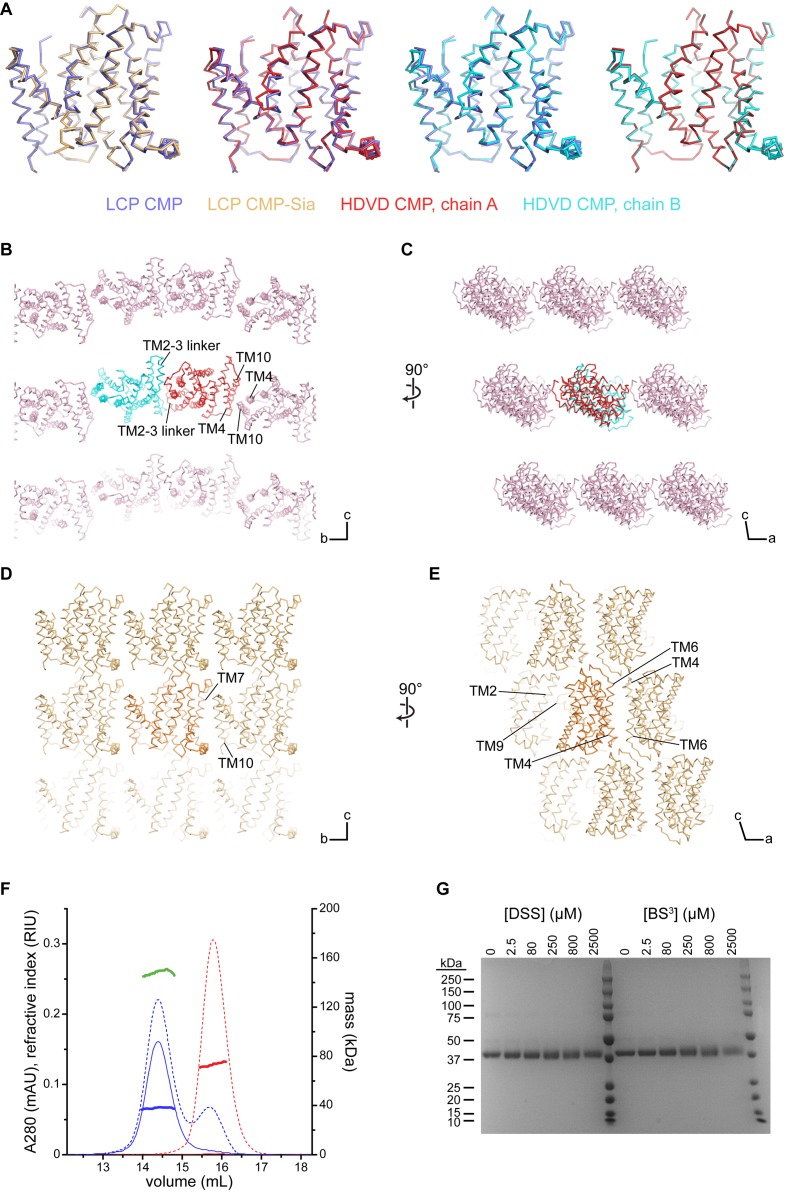
Comparison of the mCST structures and crystal lattices.(A) Side views of the indicated structures superimposed with each other. The orientations shown are the same as in Figure 2A and B. (B–D) Various views of the lattices of the mCST-CMP HDVD crystal (B and C) and the mCST-CMP-Sia LCP crystal (D and E) are shown. TMs that interact with each other at the lattice interfaces are indicated. The lattice for the mCST-CMP LCP crystal (not shown) is very similar to the mCST-CMP-Sia one. The direction of the unit cell axes are indicated in the bottom right of each panel. In the mCST-CMP HDVD crystal, the only intramembrane interactions are along the b axis (B), whereas the mCST-CMP-Sia LCP crystal has intramembrane interactions along the b (D) and a (E) axes. The TM2-3 linker interface in (B), and all of the interactions shown in (E) are antiparallel. (F) Results from the SEC-UV/LS/RI experiment. Purified human CST (hCST, blue chromatograms), which has nearly identical biochemical properties to mCST, was run on a Superdex 200 column with A280 (solid lines), refractive index (dashed lines), and light scattering (not shown) detectors inline. For comparison, a sample of DDM micelles was also run (red chromatograms). The mass of each sample is calculated across the peak using the three-detector method and is shown as the thick horizontal lines. The calculated values are as follows: 38 kDa for the protein-only component of hCST (blue line), 149 kDa for the hCST protein-lipid-detergent complex (green line), 73 kDa for the DDM micelles (red line). (G) Coomassie-stained SDS-PAGE gel showing purified hCST that was treated with increasing amounts of either disuccinimidyl suberate (DSS) or bis(sulfosuccinimidyl)suberate (BS3). The lack of cross-linking shows it is a monomer. Lanes 7 and 14 are molecular weight standards with sizes listed on the left.